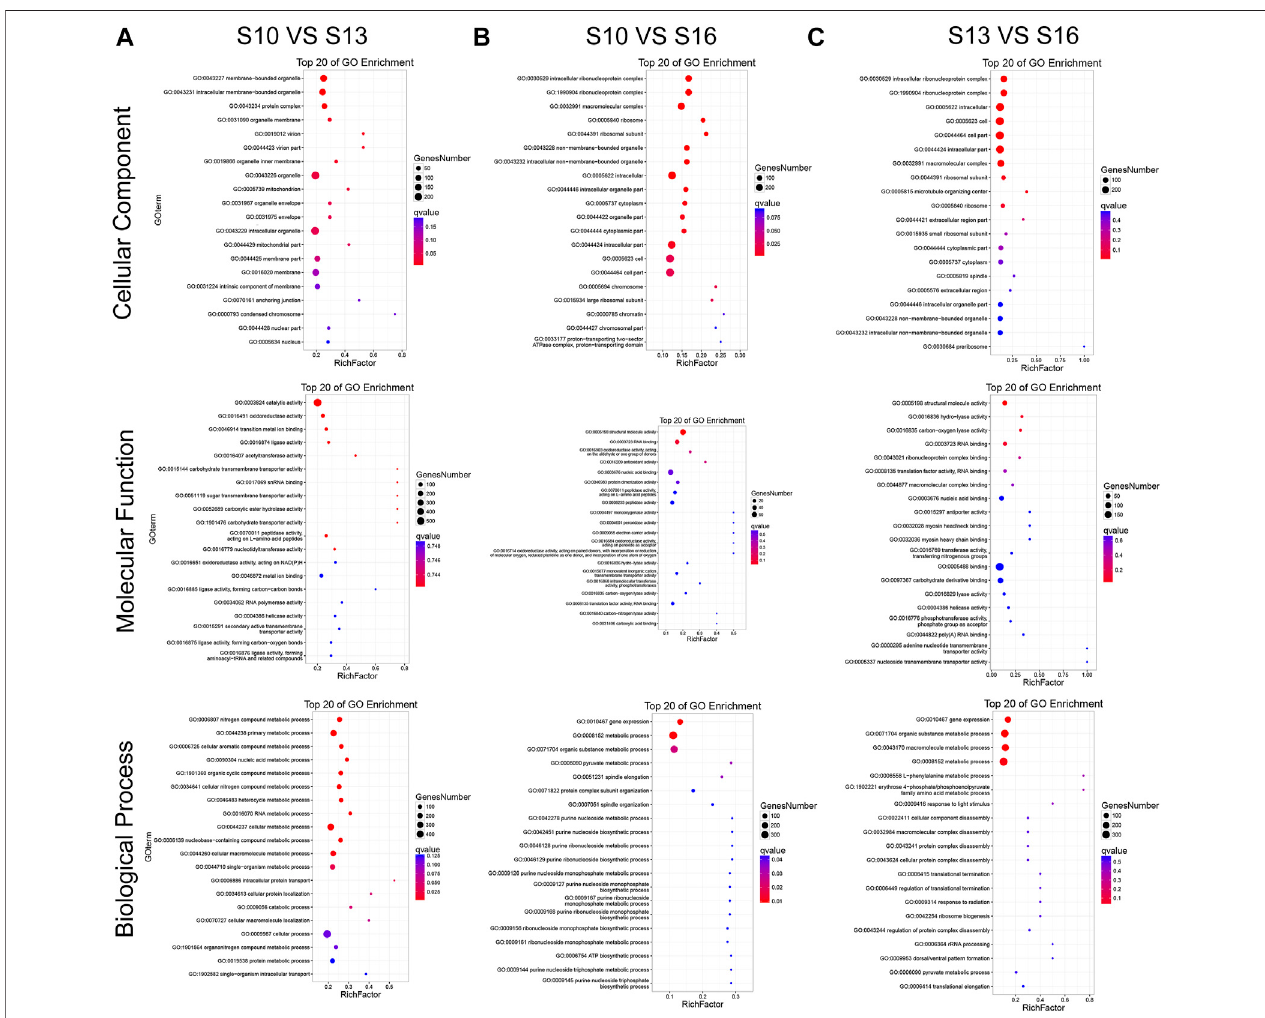
FIGURE 3 | GO enrichment classi fi cation of DEGs in the S10 vs. S13 comparison (A) , S10 vs. S16 comparison (B) and S13 vs. S16 comparison (C) .